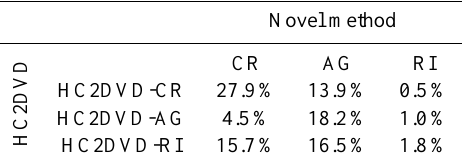
Table 6. Confusion matrix comparing the classification of ice phase hydrometeor classes during the measurement campaign of Davos as estimated from the clustering method and from the 2DVD (HC2DVD; Grazioli et al. (2014)), taken as ground reference. The comparison is conducted on three hydrometeor classes: crystal (CR), aggregates (AG), and rimed-ice particles (RI). In this case, the matrix is 3 × 3, with similar classes in rows and columns, and it can be used to evaluate quantitatively the agreement among meth- ods. The overall accuracy of the comparison is 49%, and Cohen’s kappa is